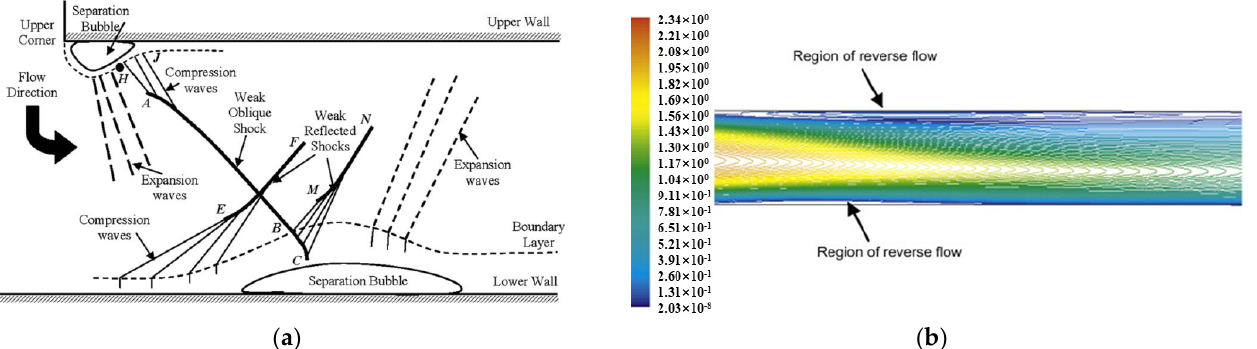
Figure 13. Flow field results in the literature: ( a ) qualitative representation of the shock/boundary layer interaction, and ( b ) details of the shock wave region. Reprinted/adapted with permission from Ref. [94]. 2022, Qi Zhao.